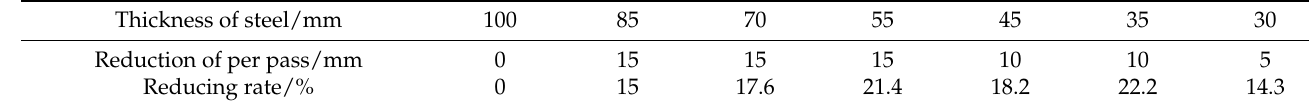
Table 2. The parameters about the degree of deformation during hot rolling.